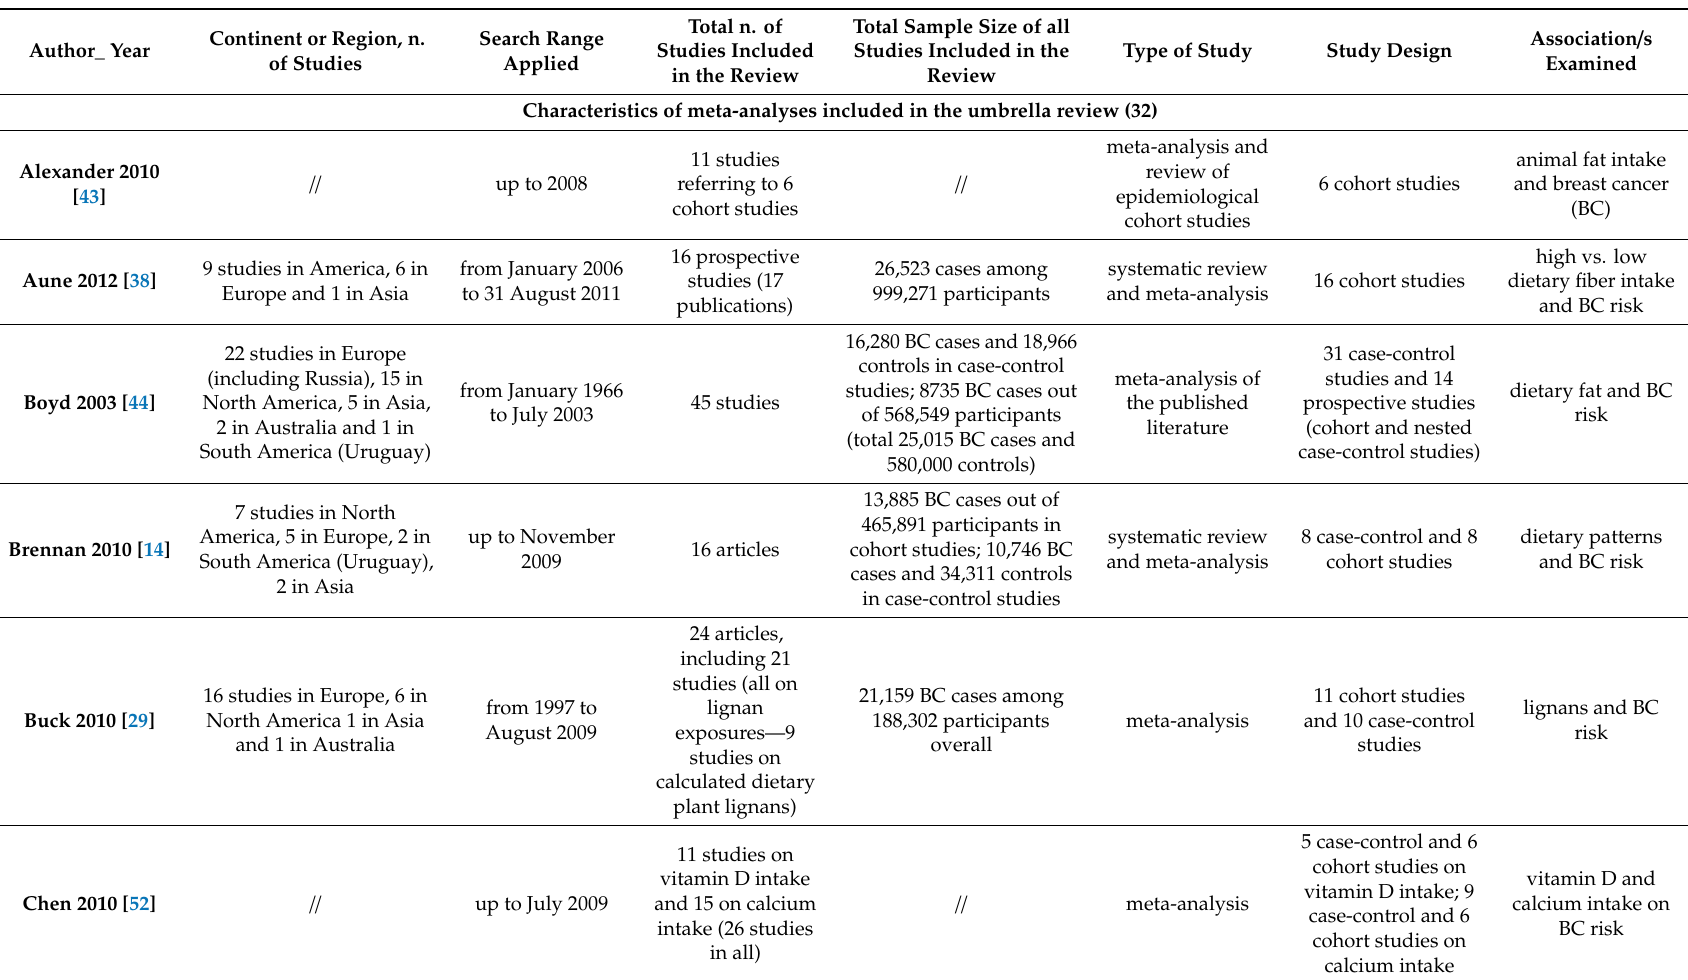
Table 1. Characteristics of studies included in the umbrella